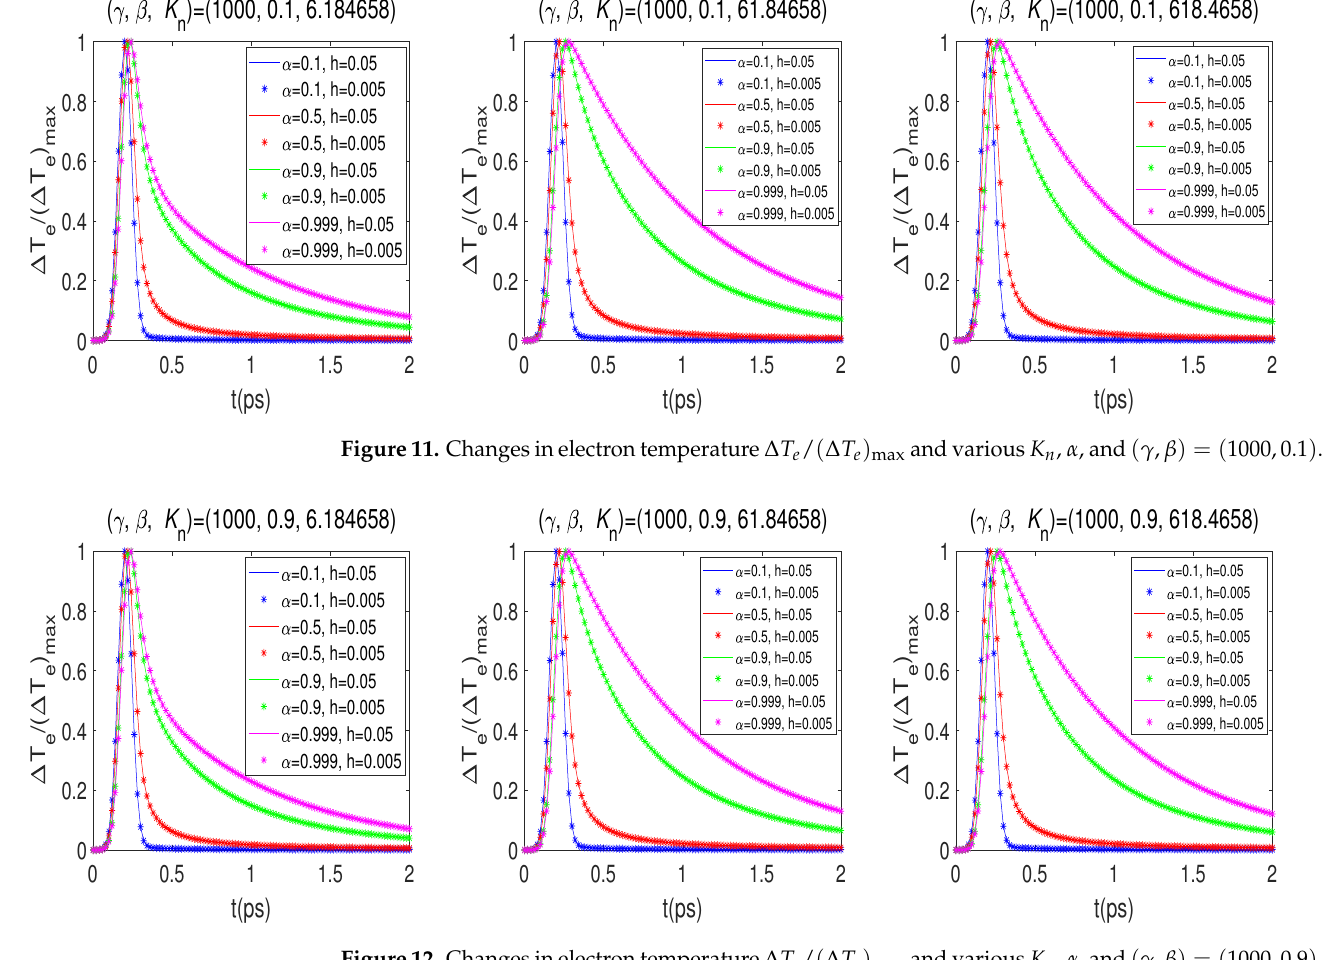
Figure 12. Changes in electron temperature ∆ T e / ( ∆ T e ) max and various K n , α , and ( γ , β ) = ( 1000,0.9 ) .